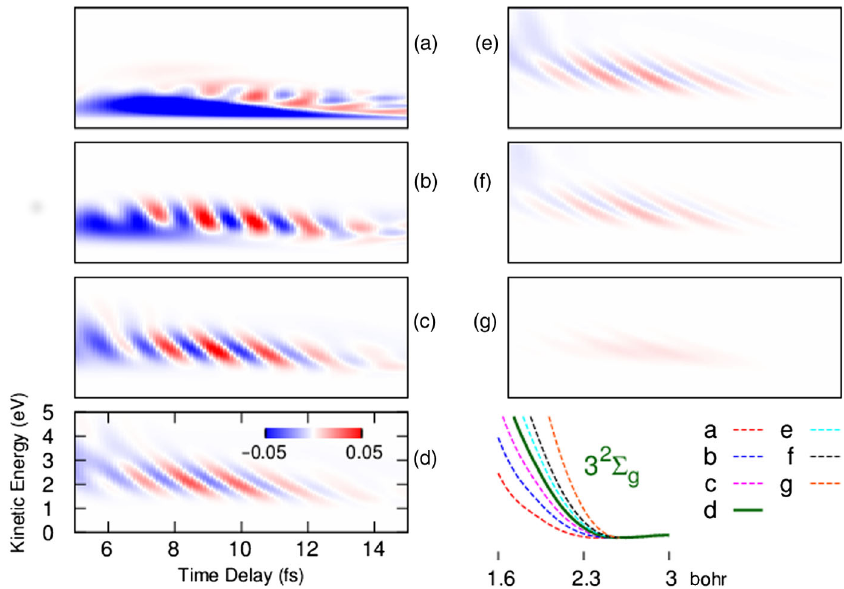
FIG. 9. (a) – (g) Time-dependent N þ kinetic energy spectra corresponding to the set of gradients of the 3 2 Σ bottom right-hand panel [(d) corresponds to the unaltered 3 2 Σ probe pulse are